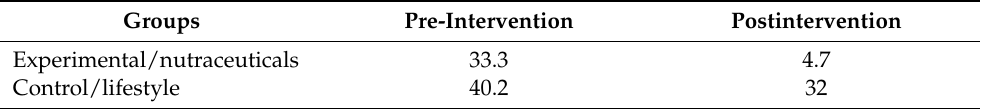
Table 3. Current health symptoms (% of participants who have).